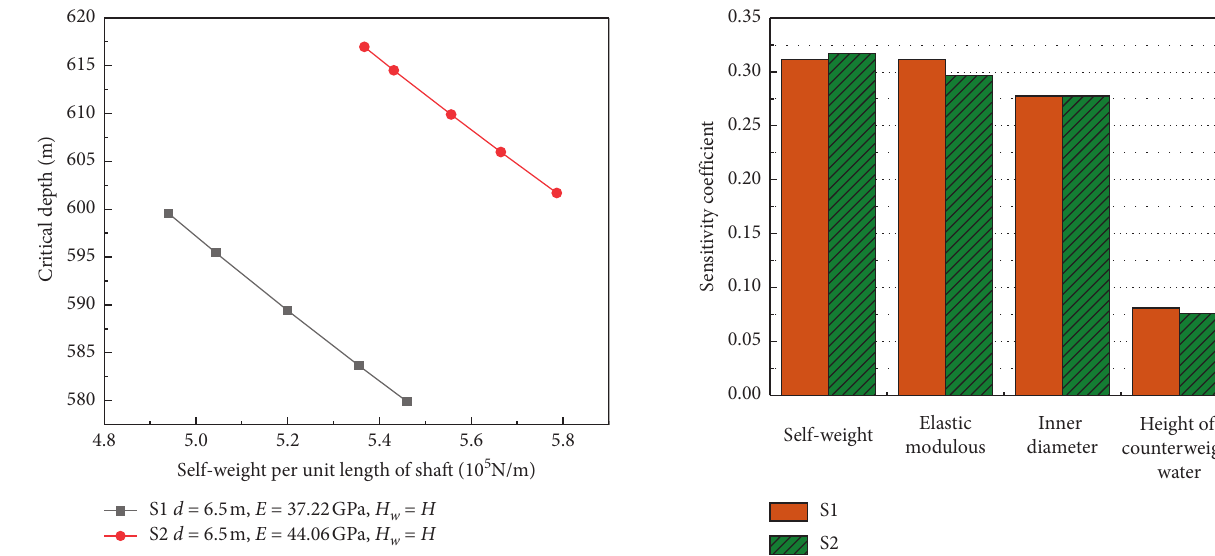
Figure 9: Sensitivity analysis chart of influencing